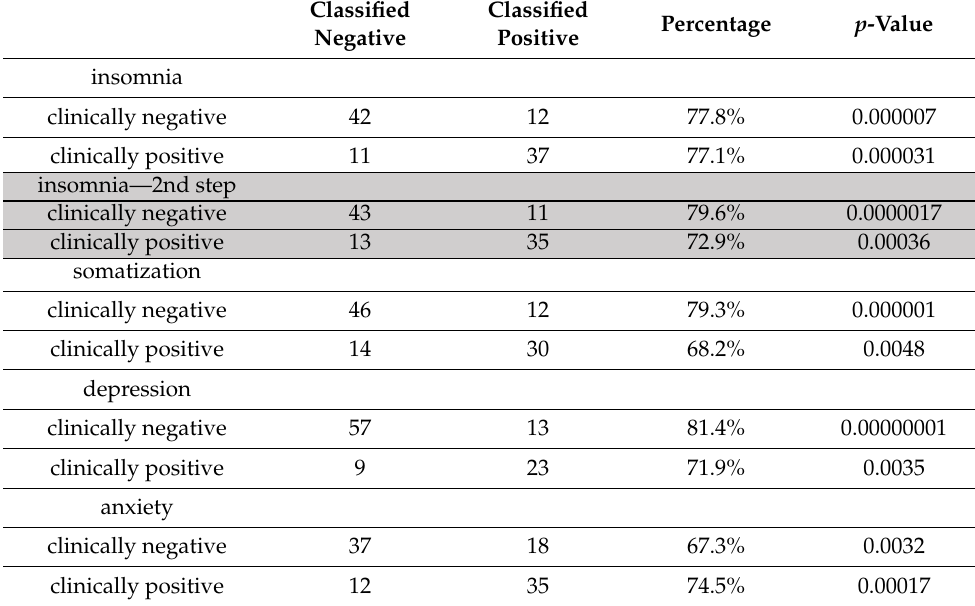
Table 1. Eight-five cortical and subcortical regional measures were trained as linear classifiers by groups determined by symptom survey clinical thresholds. Jackknifed classification accuracies are shown. The results for insomnia (2nd step) are highlighted in gray. These were obtained when the regions which were selected for the first classification analysis were excluded. Symptom survey scores and regional neuroelectric measures were used from both baseline ( n = 62) and follow-up ( n = 40) sessions for all subjects of the traumatic brain injury (TEAM-TBI) cohort. See the text for